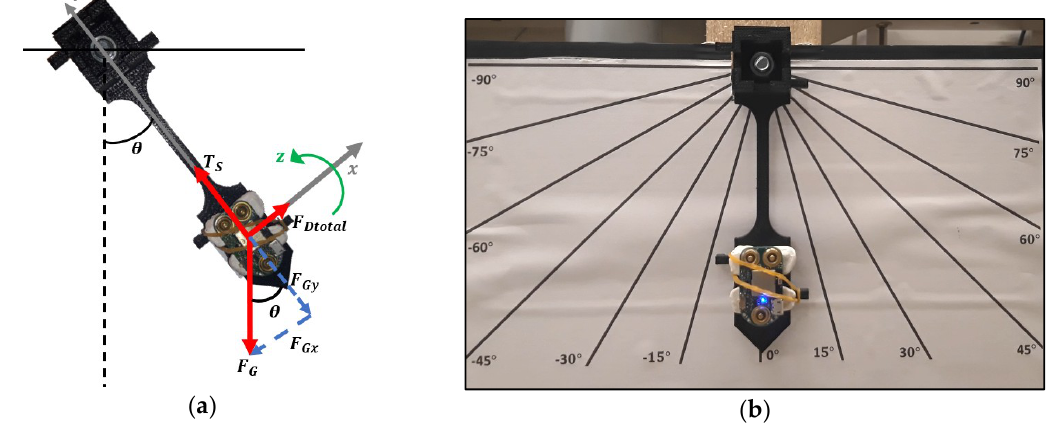
Figure 9. Customized pendulum for inertial data validation: ( a ) Forces diagram of the pendulum system; ( b ) Pendulum with the hardware attached and the marked angles behind for data acquisition.